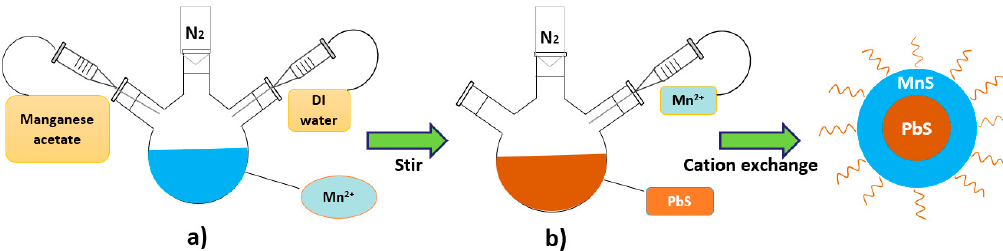
Figure 1. The schematic diagram of the preparation of PbS/MnS core shell quantum dots (QDs). ( a ) Preparation of Mn 2+ precursor and ( b ) preparation of PbS/MnS core shell QDs.